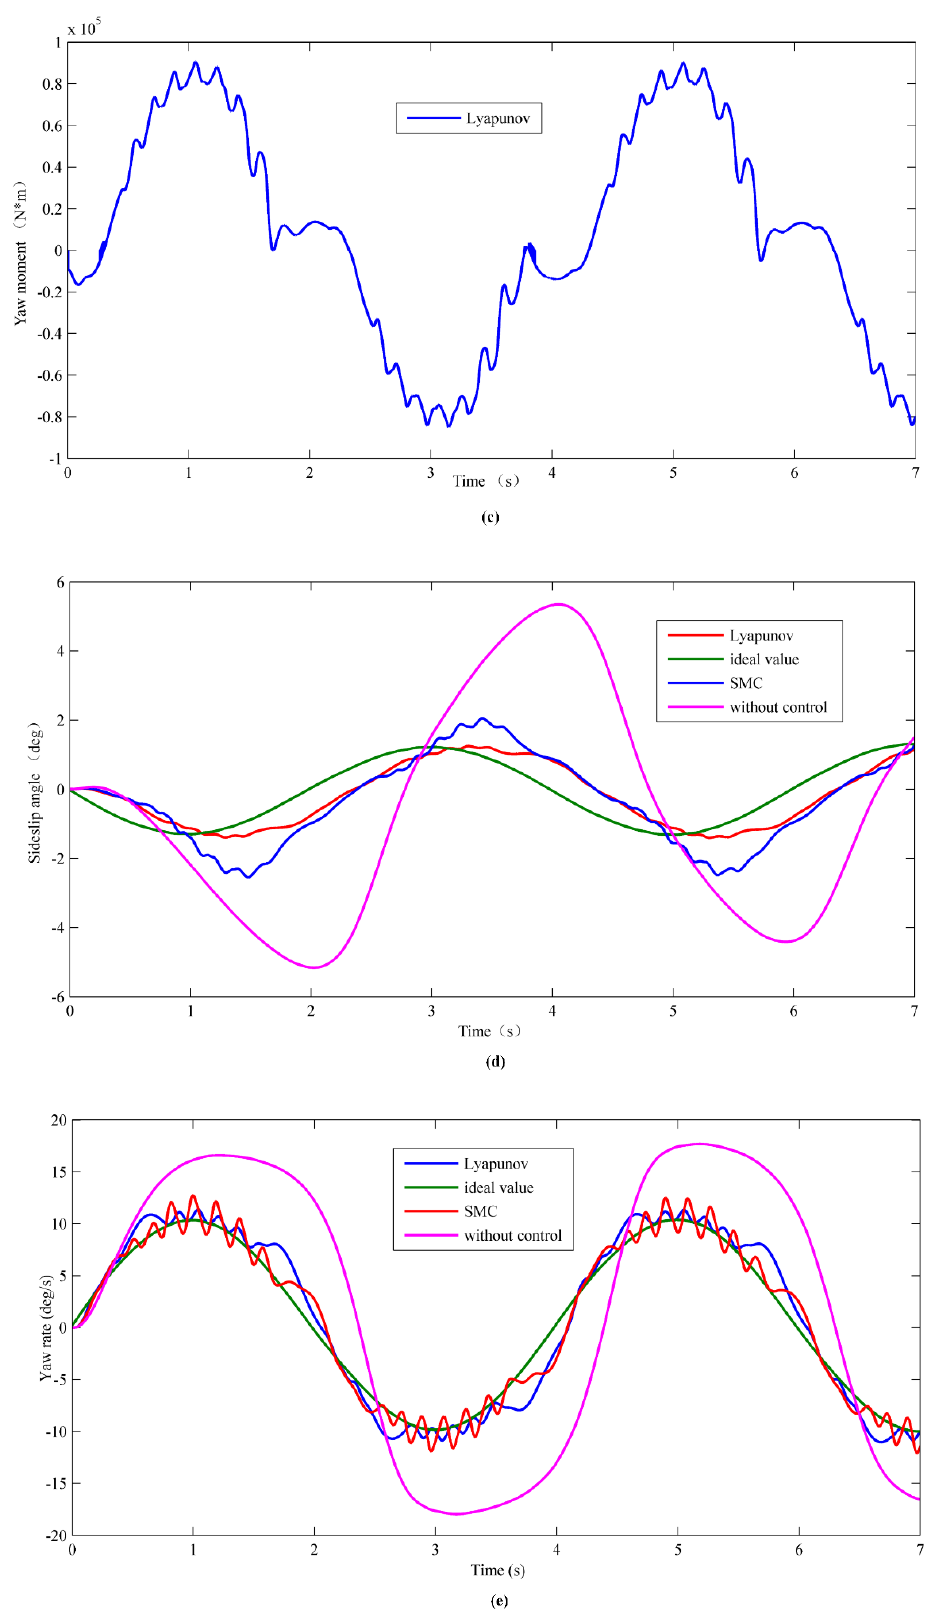
Figure 4. Serpentine test results: ( a ) steering wheel angle; ( b ) yaw moment response curve in SMC control mode; ( c ) yaw moment response curve in Lyapunov control method; ( d ) control results of sideslip angle; ( e ) control results of yaw